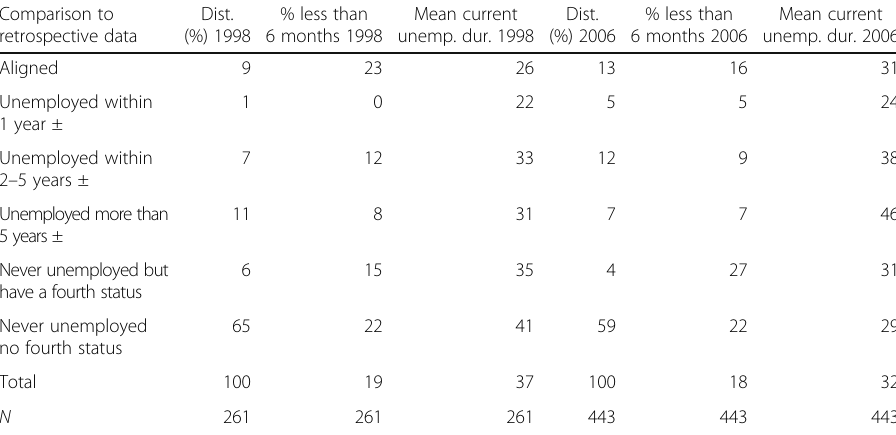
Table 1 Patterns of unemployment reporting as reported in 1998 or 2006 versus 2012 retrospective data for 1998 or 2006, individuals reporting contemporaneous unemployment in 2006 or 1998 and present in